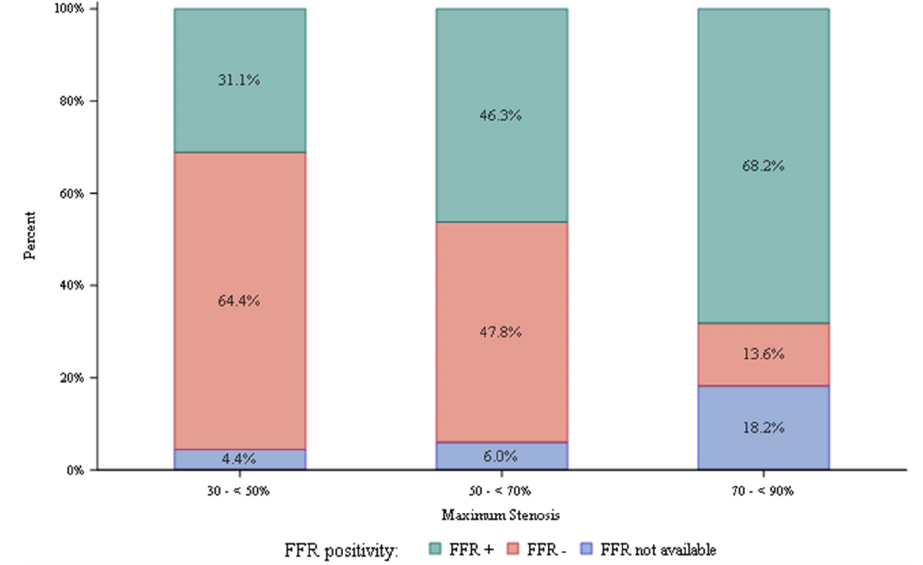
Figure 1. Fractional flow reserve from coronary computed tomography angiography (FFR CT ) results stratified according to computed tomography angiography stenosis diameter reduction. Nadir FFR CT ≤ 0.80 was positive. Nadir FFR CT > 0.80 was negative. J. Clin. Med. 2020 , 9 , x FOR PEER REVIEW